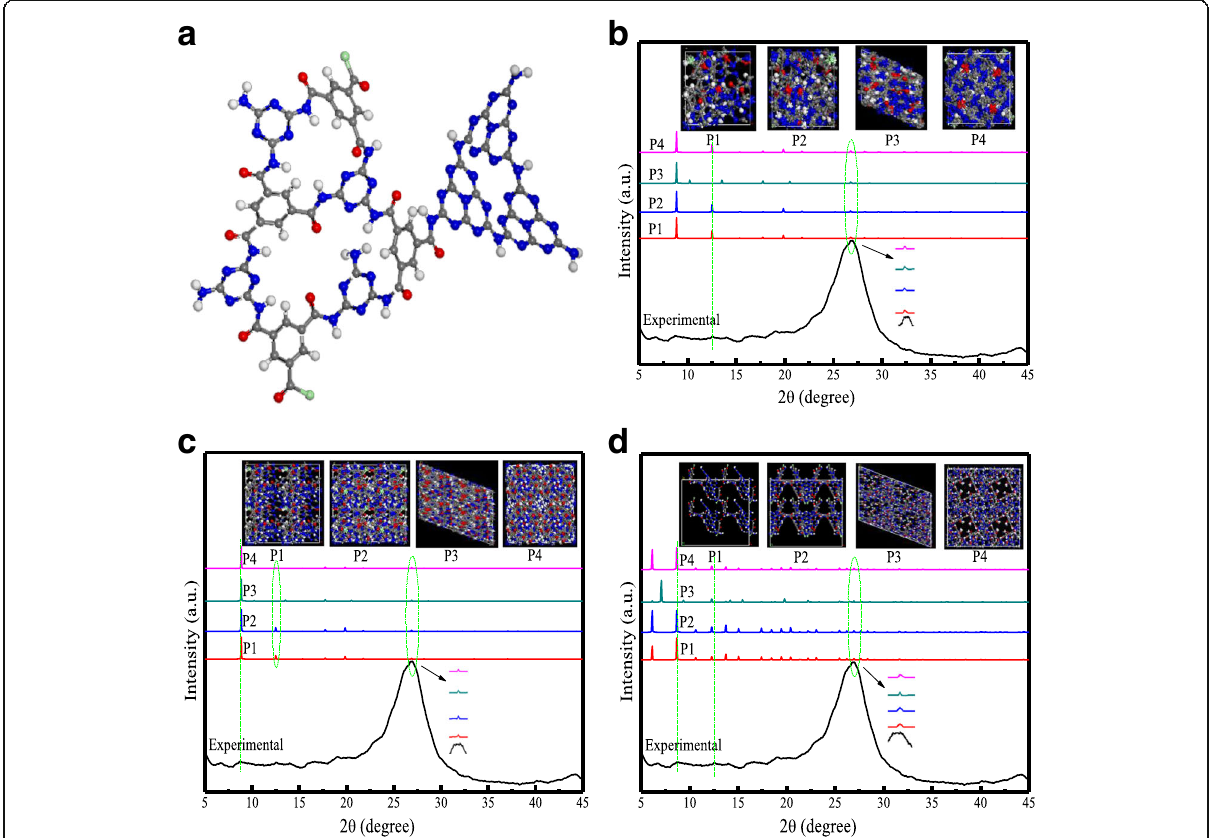
Fig. 2 a Energy-optimized structural monomer representation and b – d the comparison of XRD patterns for CN